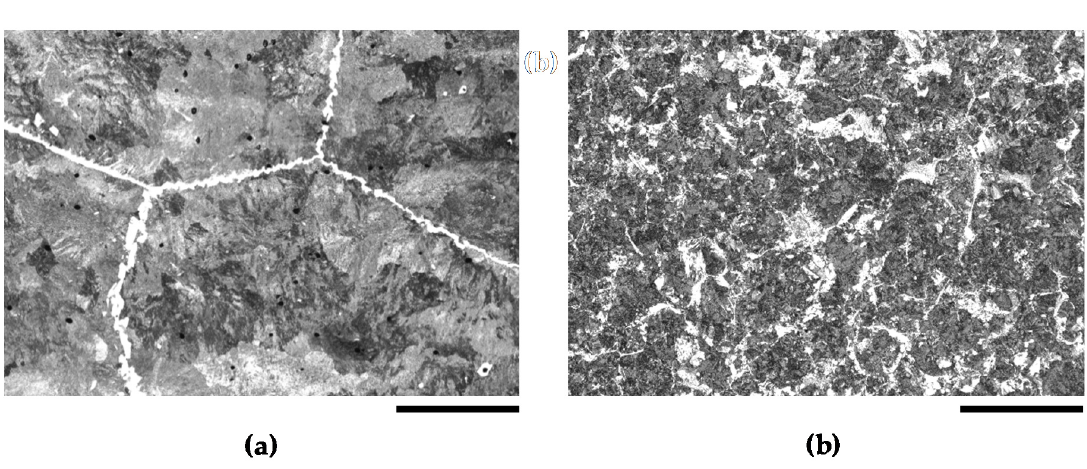
Figure 12. As-supplied structure of the EN 13262-ER7-grade steel ( a ) and microstructure of the axle Figure 12. As ‐ supplied structure of the EN 13262 ‐ ER7 ‐ grade steel ( a ) and microstructure of the axle area after the NSF process ( b ). Scale bar: 500 µ area after the NSF process ( b ). Scale bar: 500 μ m.